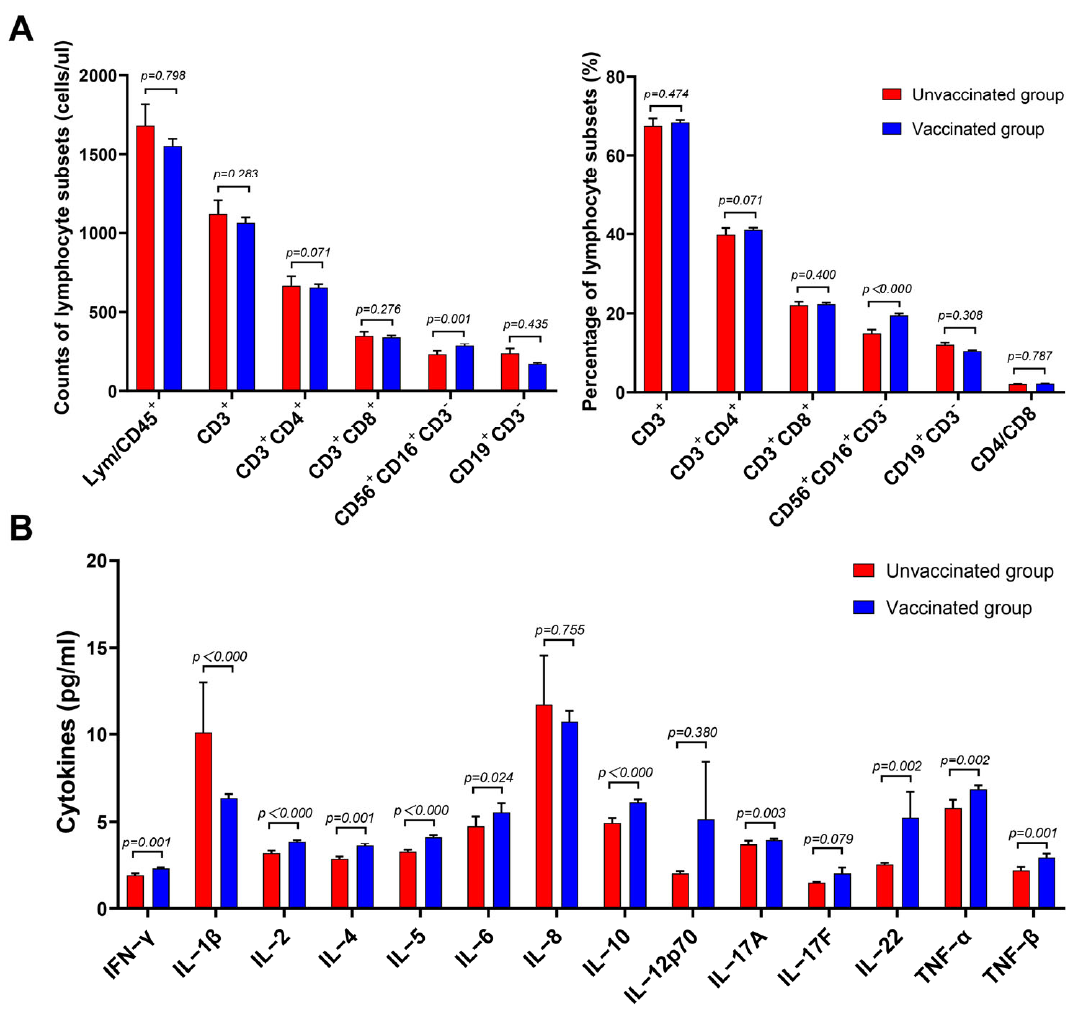
Figure 1. Comparison of the lymphocyte subsets and cytokines between the unvaccinated and vac- cinated groups. ( A ) Absolute numbers and percentage of lymphocyte subsets and the CD4 + /CD8 + T-cell ratio. ( B ) Graphical representation of the concentrations of different cytokines in the unvac- cinated and vaccinated groups. Unvaccinated group, n = 102; vaccinated group, n = 406. All p values were two-tailed, and di ff erences with p < 0.05 were considered statistically signi fi cant. ns, not sig- ni fi cant.